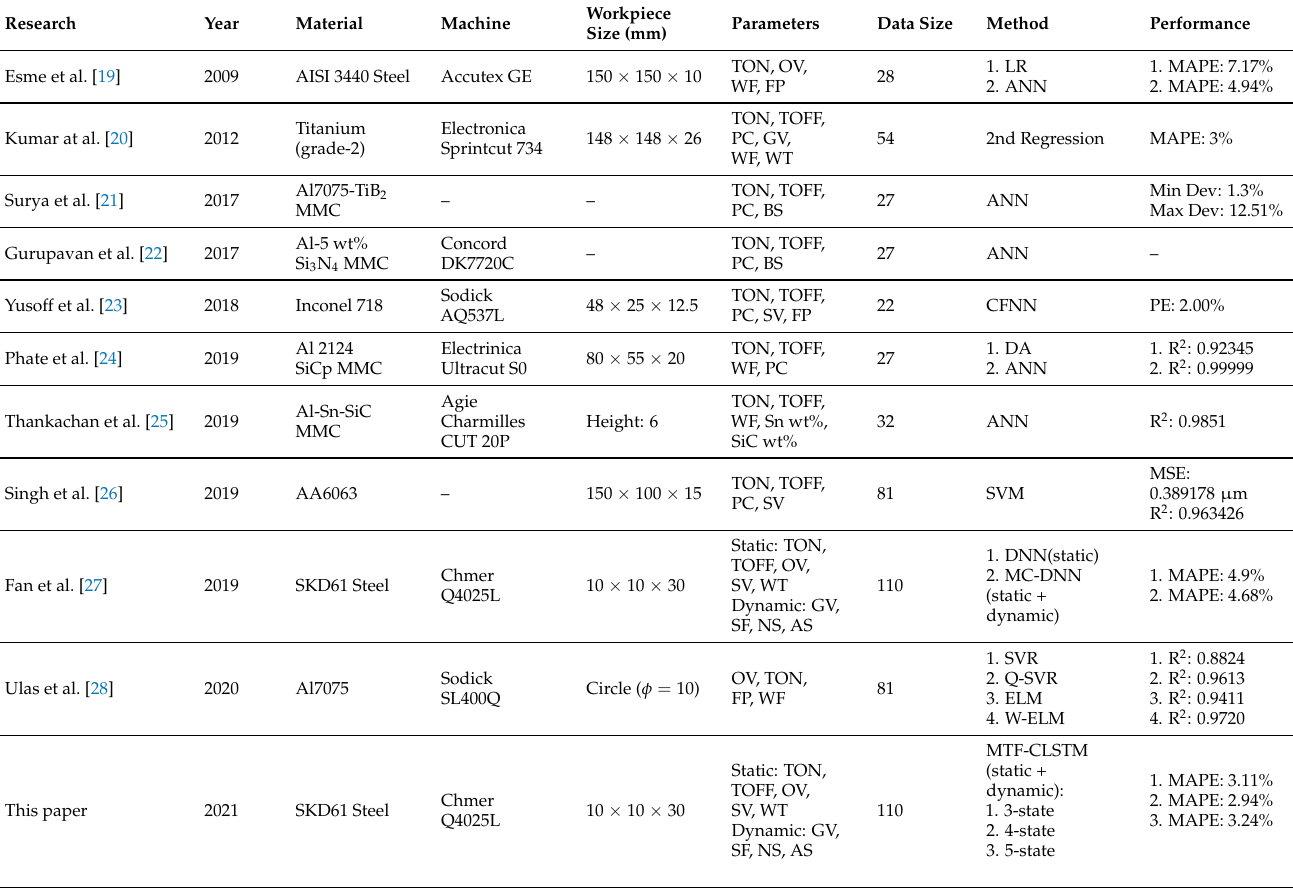
Figure 10. The prediction and the fact of the surface roughness Ra in the unit of m for 10 testing data for the proposed MTF-CLSTM method with 3-, 4-, and 5-state MTF. Table 1 shows the comparisons of the proposed method with related methods [19–28] predicting WEDM workpiece surface roughness. Among the compared methods, the MC- DNN method proposed in [27] is the only method that is like MTF-CLSTM to predict WEDM workpiece surface roughness by using static machining parameters and dynamic manufacturing conditions. By Table 1, it can be observed that the proposed MTF-CLSTM method significantly outperforms the MC-DNN method for all the cases of the 3-, 4-, and 5-state MTFs in terms of surface roughness prediction error MAPEs. Table 1. Comparisons of the proposed method with related research predicting WEDM surface